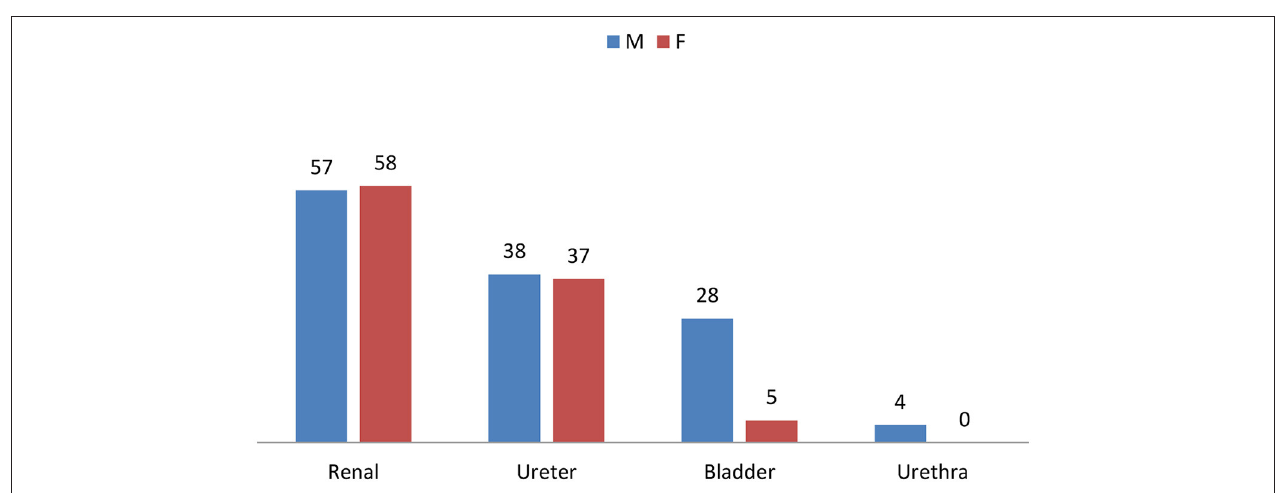
FIGURE 2 | Stone locations based on gender